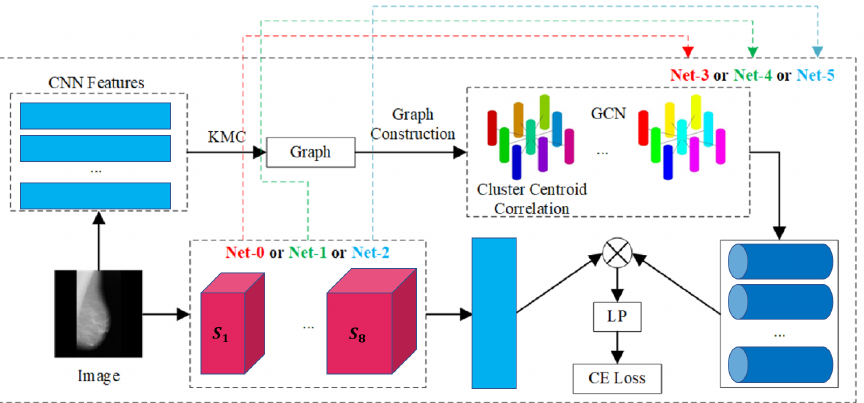
Figure 8. Illustration of the framework that combines CNN and GCN features. Bottom row shows the CNN pipeline to extract image-based features while the top row illustrates the GCN pipeline to learn the interactions. Image adapted from